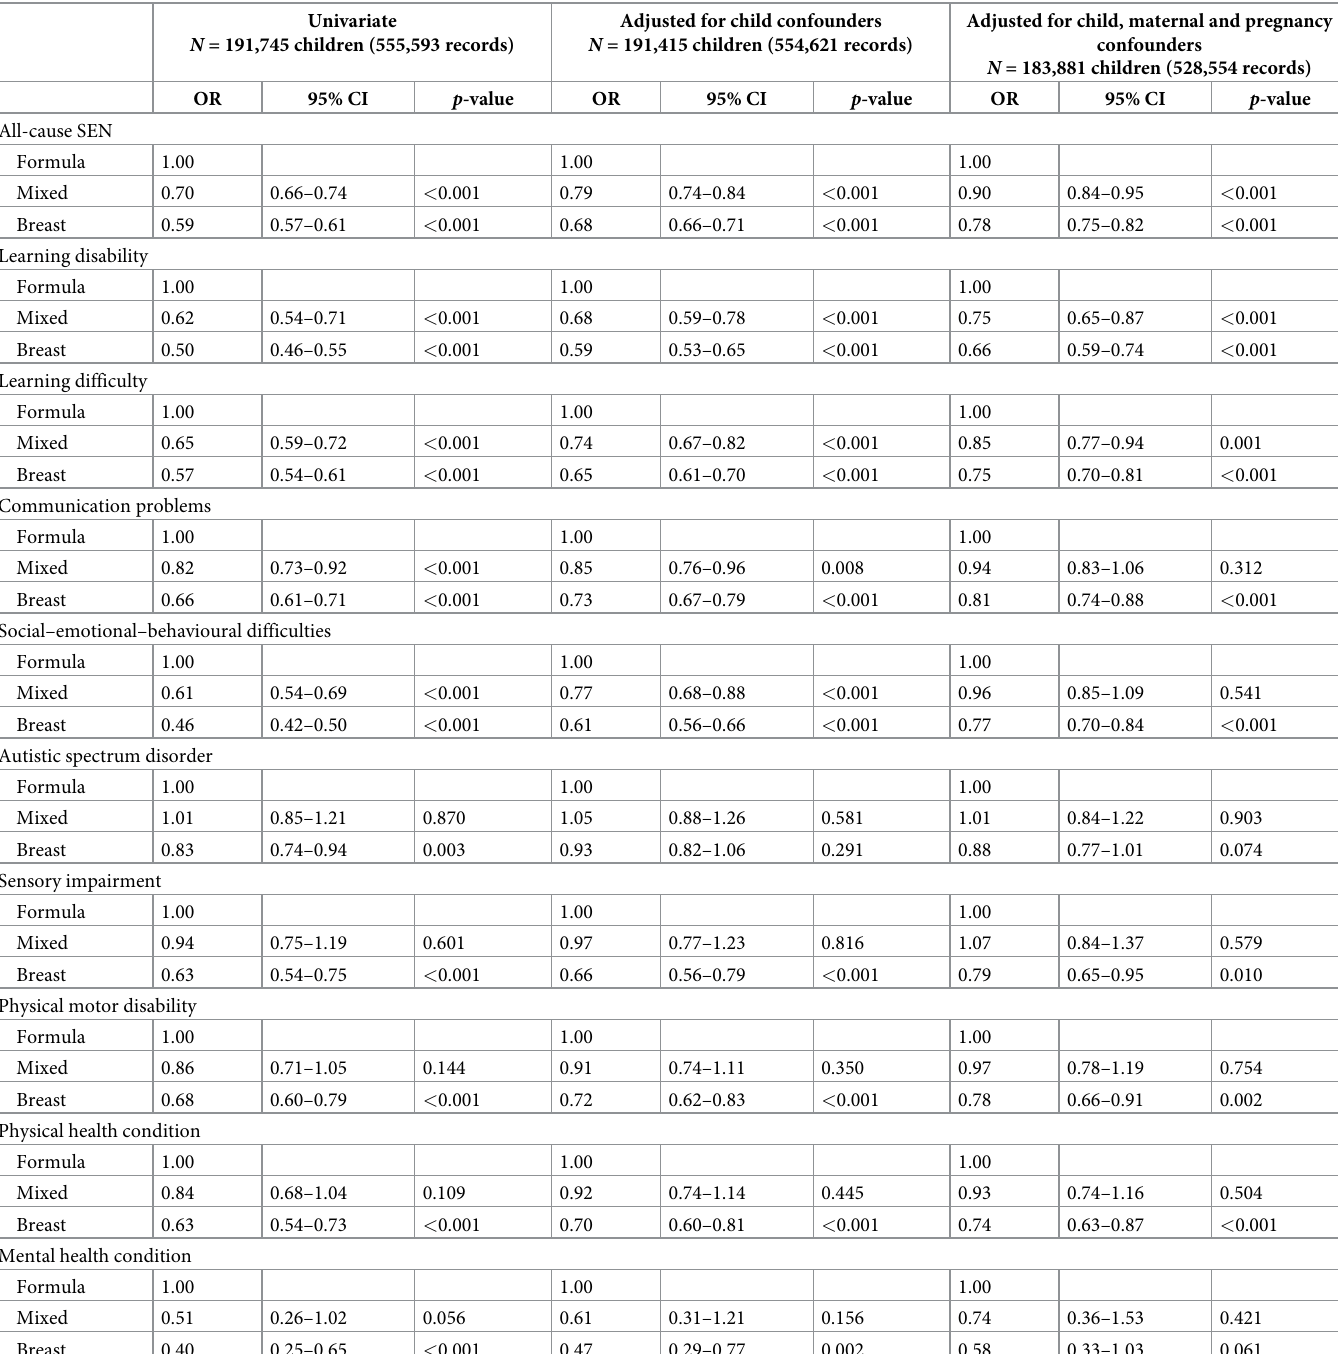
Table 3. Univariate and multivariate associations between infant feeding method at 6–8 weeks of age and all-cause and cause-specific